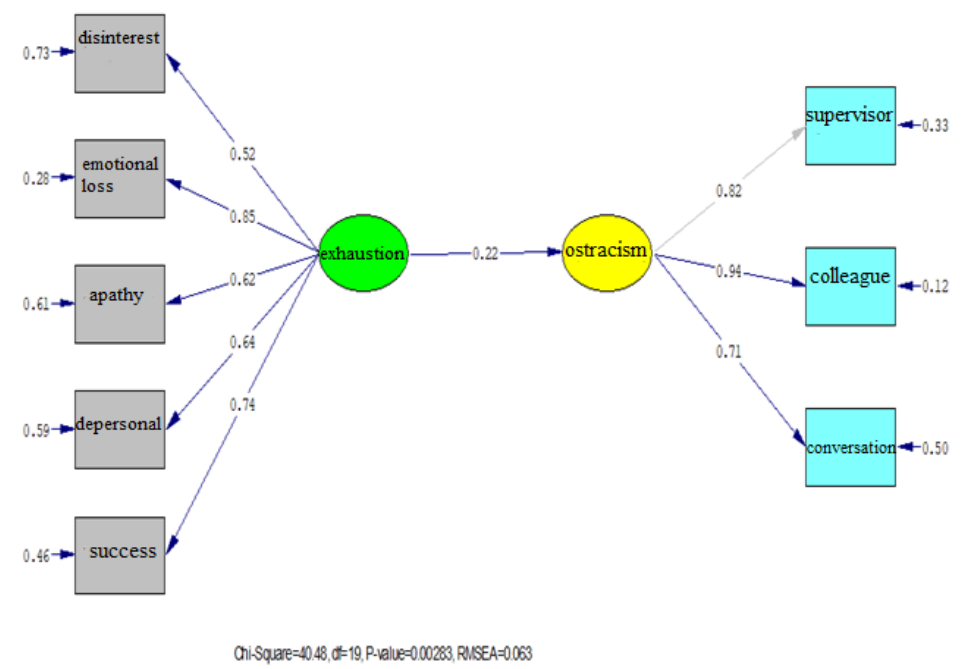
Figure 1. Research Model on Standard Coefficients Mode about Role of Emotional Exhaustion on Workplace Ostracism.